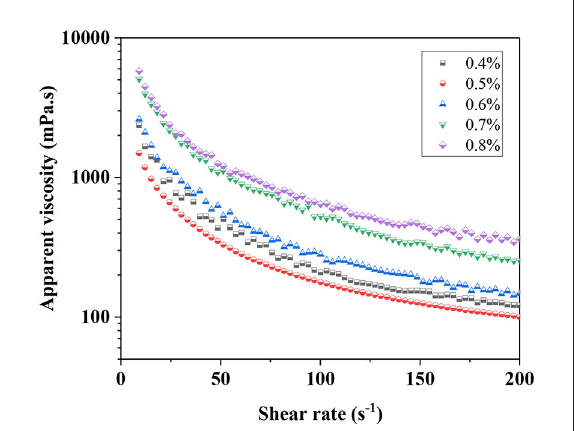
FIGURE3 Apparent viscosity of S/O/W calcium-lipid emulsions at different concentrations of PGA-XG complexes (0.4, 0.5, 0.6, 0.7, and 0.8 wt%) determined by rotation